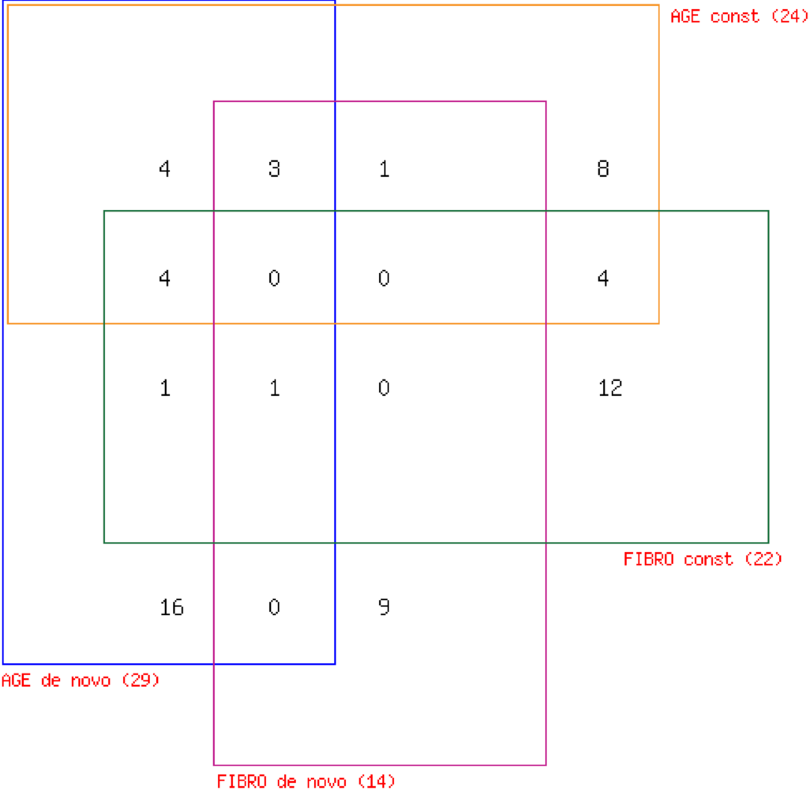
Figure 2. Venn diagram representing genes shared by or unique to AGE and FIBRO CNVs.